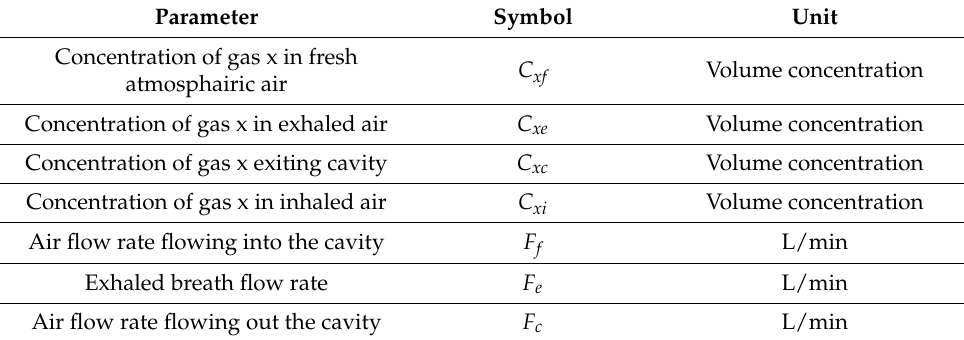
Table 1. Analysis